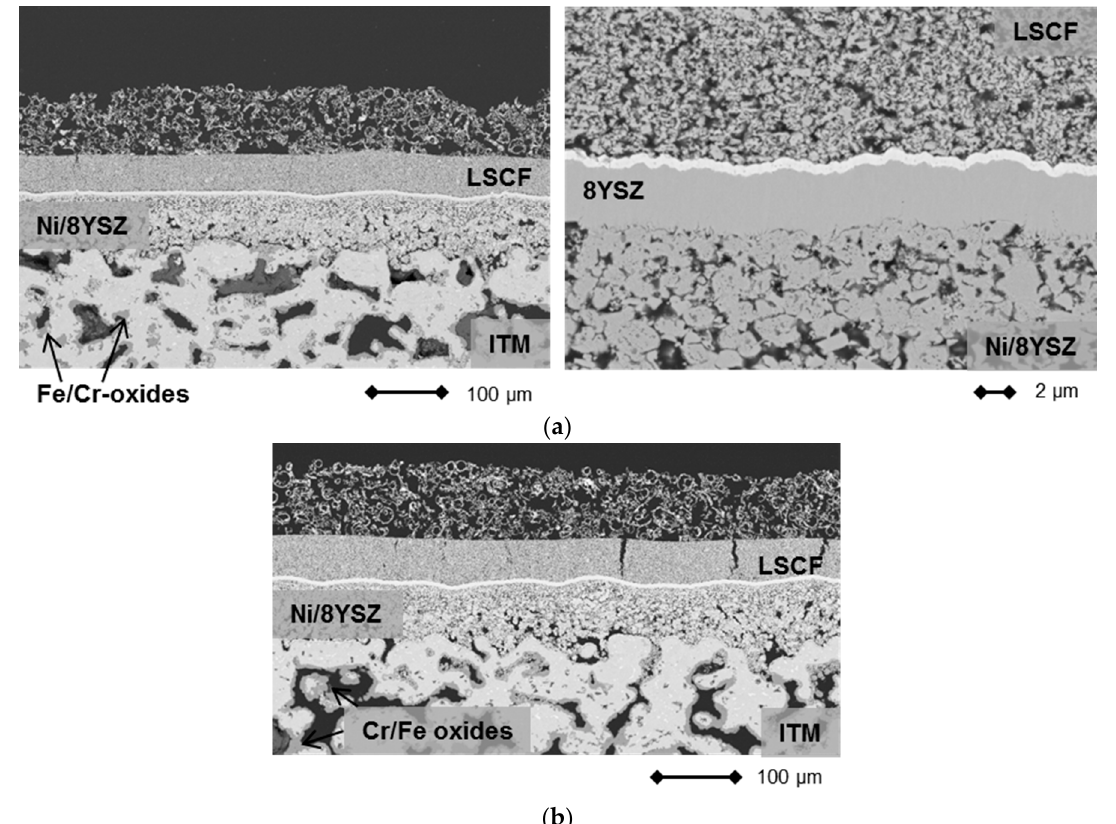
Figure 4. ( a ) SEM images of cross sections of cell 1 after operation at 750 °C under load (0.3 A/cm 2 ). The dark gray areas within the metal substrate ITM (intermediate temperature metal, Plansee SE, Reutte, Austria) are comprised of chromium and iron oxides; and ( b ) SEM images of cross-sections of cell 2 after operation at 750 °C under load (0.3 A/cm 2 ). The dark gray areas within the metal